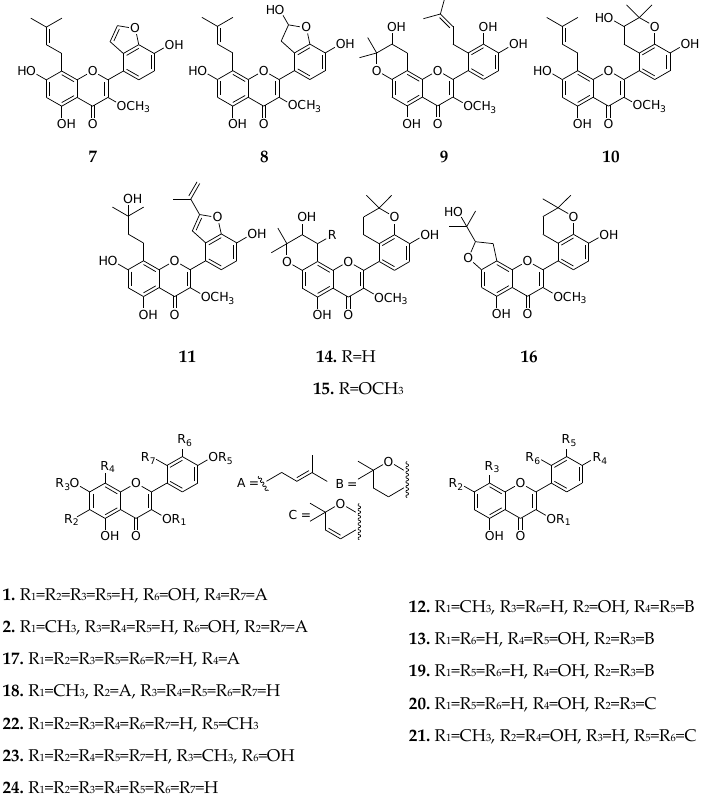
Figure 1. Structures of compounds 1 – 24.